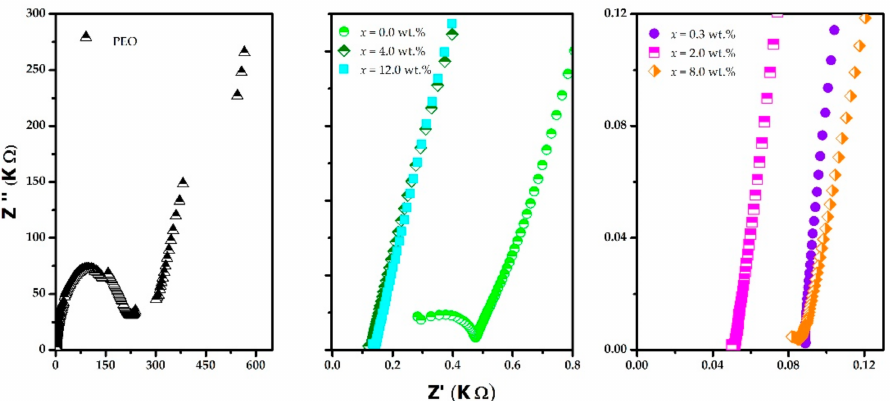
Figure 6. Nyquist diagrams for PEO and for (PEO) 4 CF 3 COOLi electrolyte with different combinations of